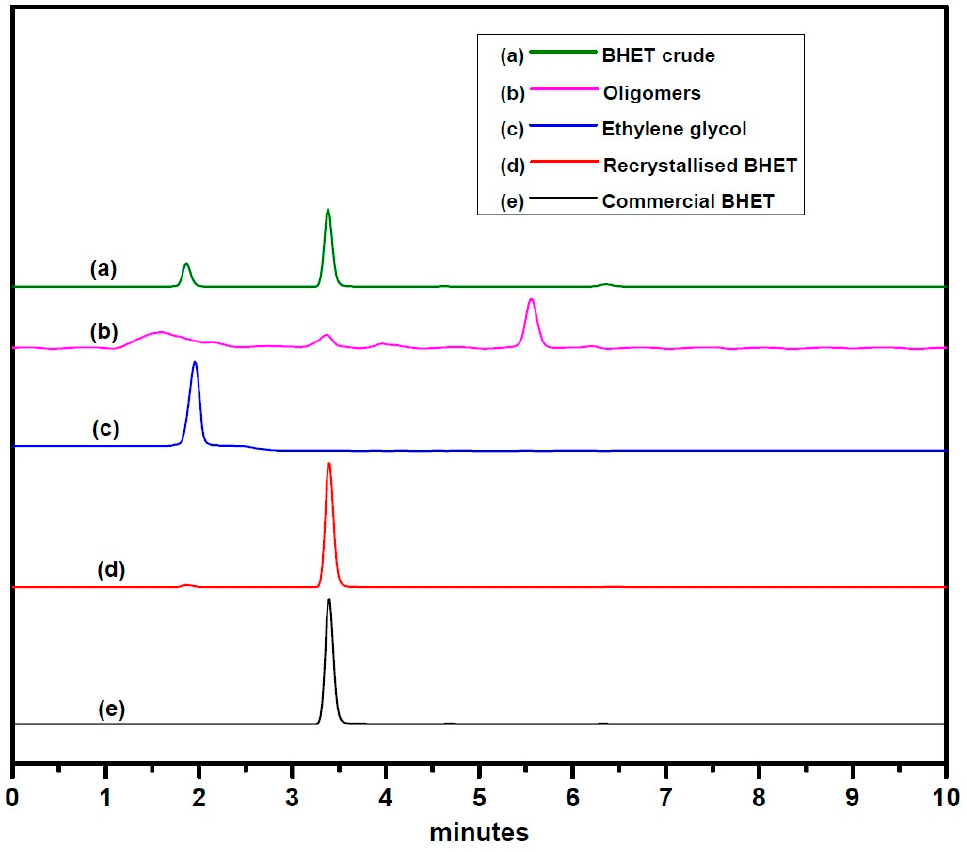
Figure 4. HPLC data of—( a ) the crude product, ( b ) water ‐ insoluble part, ( c ) ethylene glycol, ( d ) recrystallized bis(2 ‐ hydroxyethyl terephthalate) (BHET), and ( e) commercially available BHET. In its FT ‐ IR spectra, four prominent peaks were observed at υ = 3420 cm − 1 , 1726 cm − 1 ,